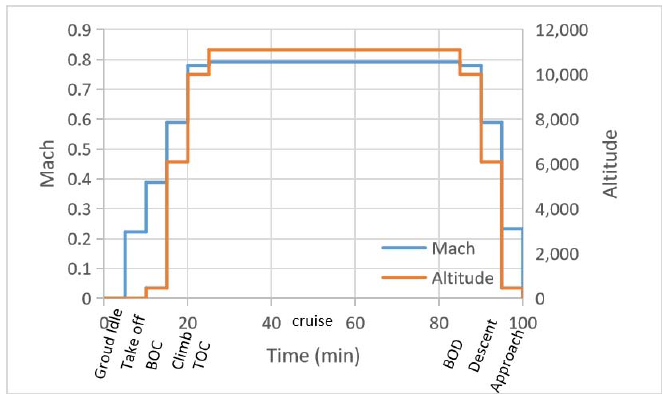
Figure 16. Flight conditions in a typical flight mission.